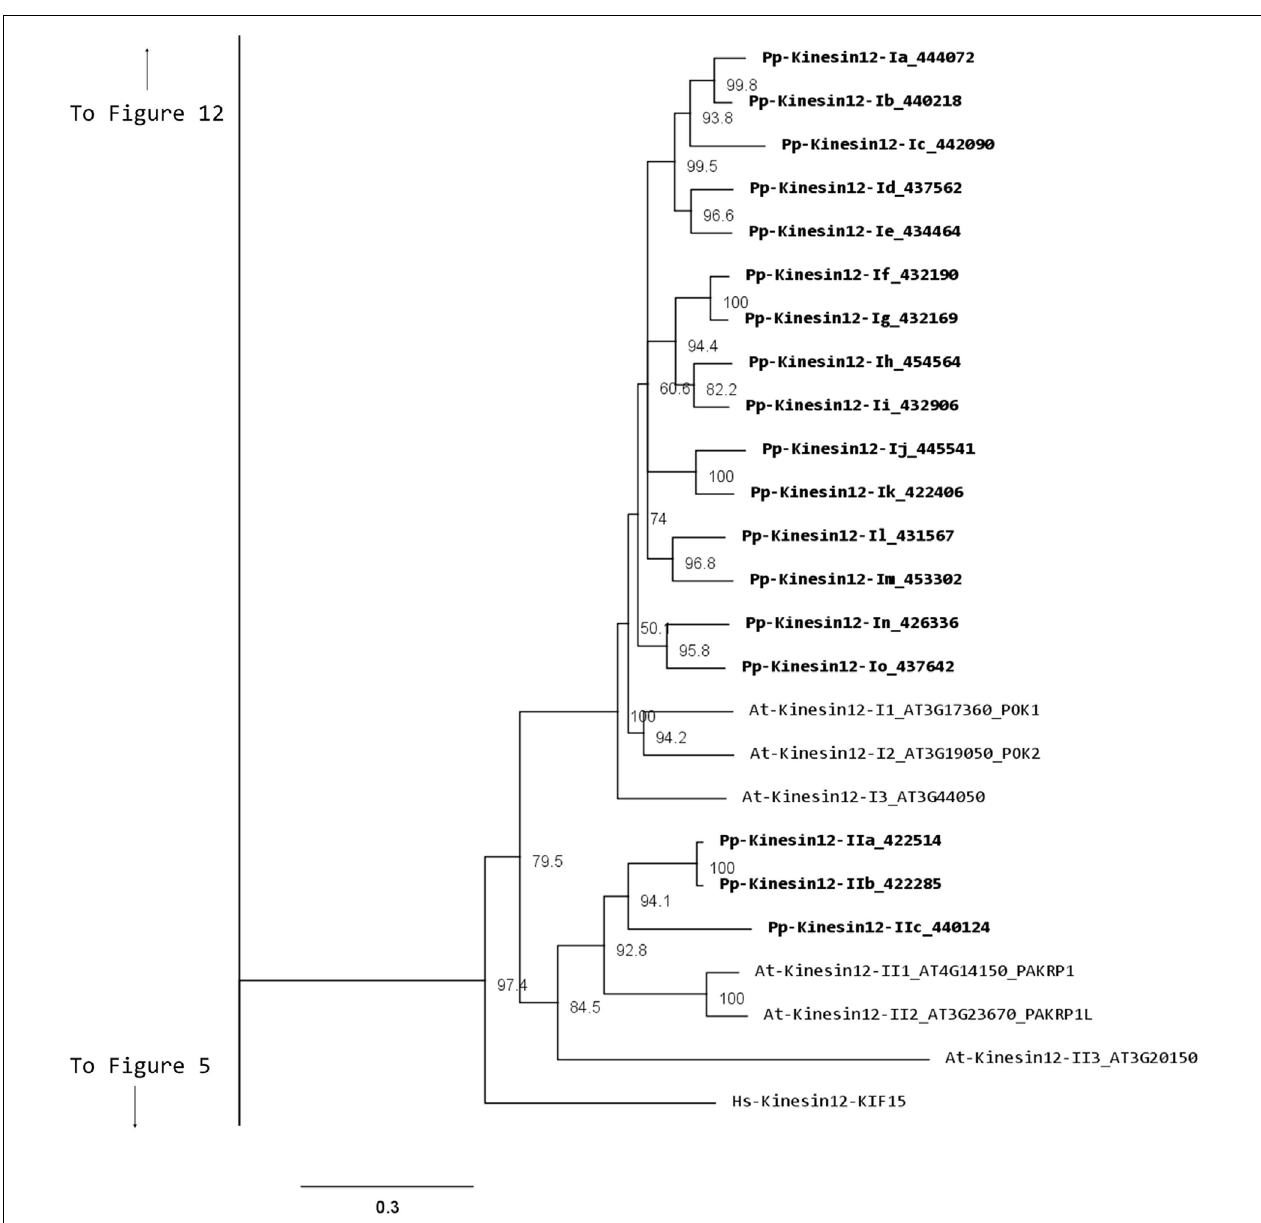
the statistical support of values above 50%.The scale shows the estimated branch length corresponding to the number of substitutions per site.The Physcomitrella numbers correspond to the Phypa number uniquely associated with each gene model (version 1.6) at